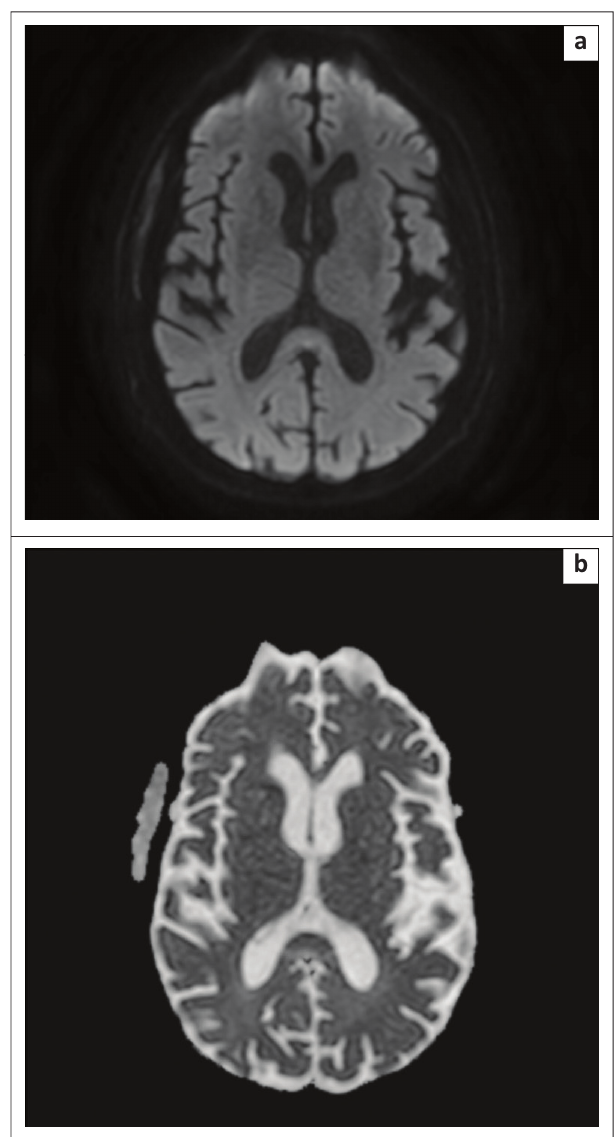
FIGURE 4: (a) Diffusion sequence showing resolution of the splenium lesion at follow up (b) Apparent diffusion coefficient map showing complete resolution of the splenium lesion at follow up imaging; compare with Figure